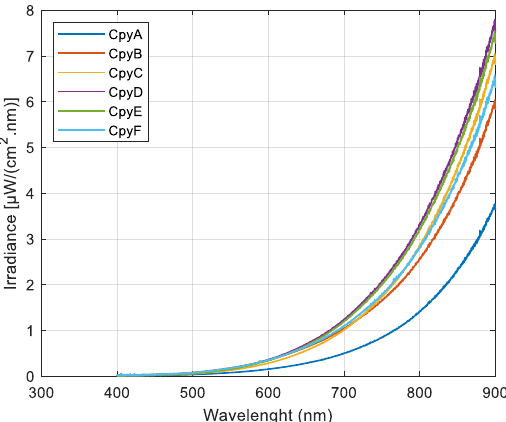
Figure 3. Average emission spectrum of chalcopyrite combustion at different sizes.